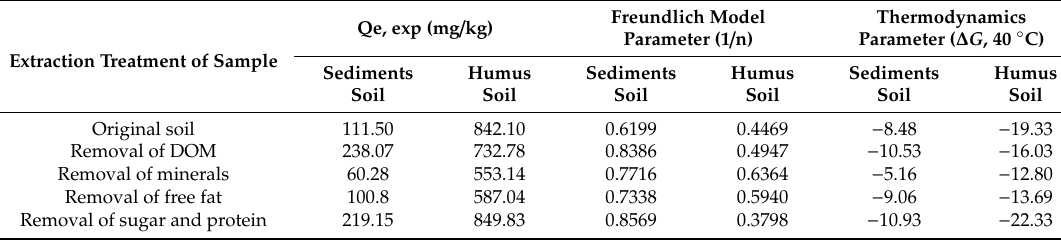
Table 6. Comparison of the OTC adsorption by di ff erent soil organic